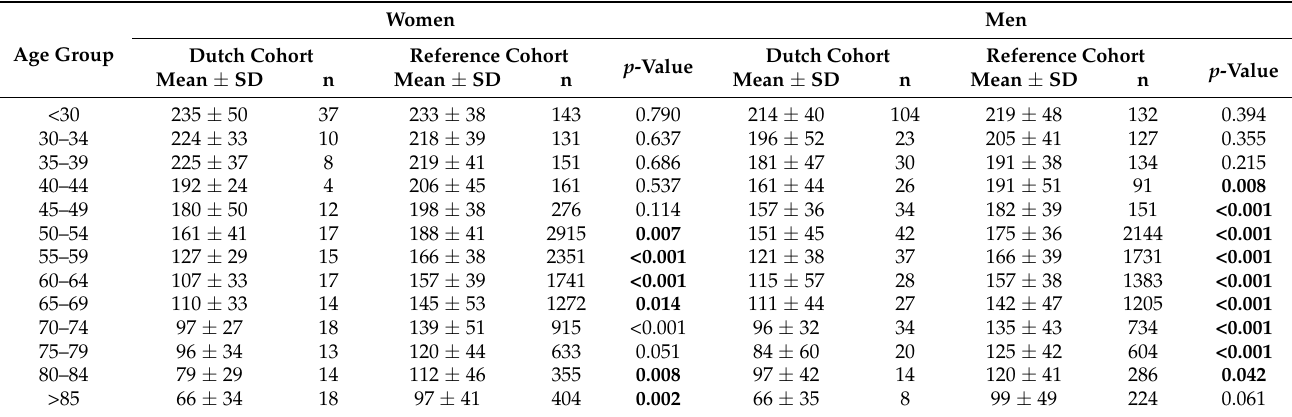
Table A2. Sex-specific differences in BMD per age group between the North American cohort and Dutch